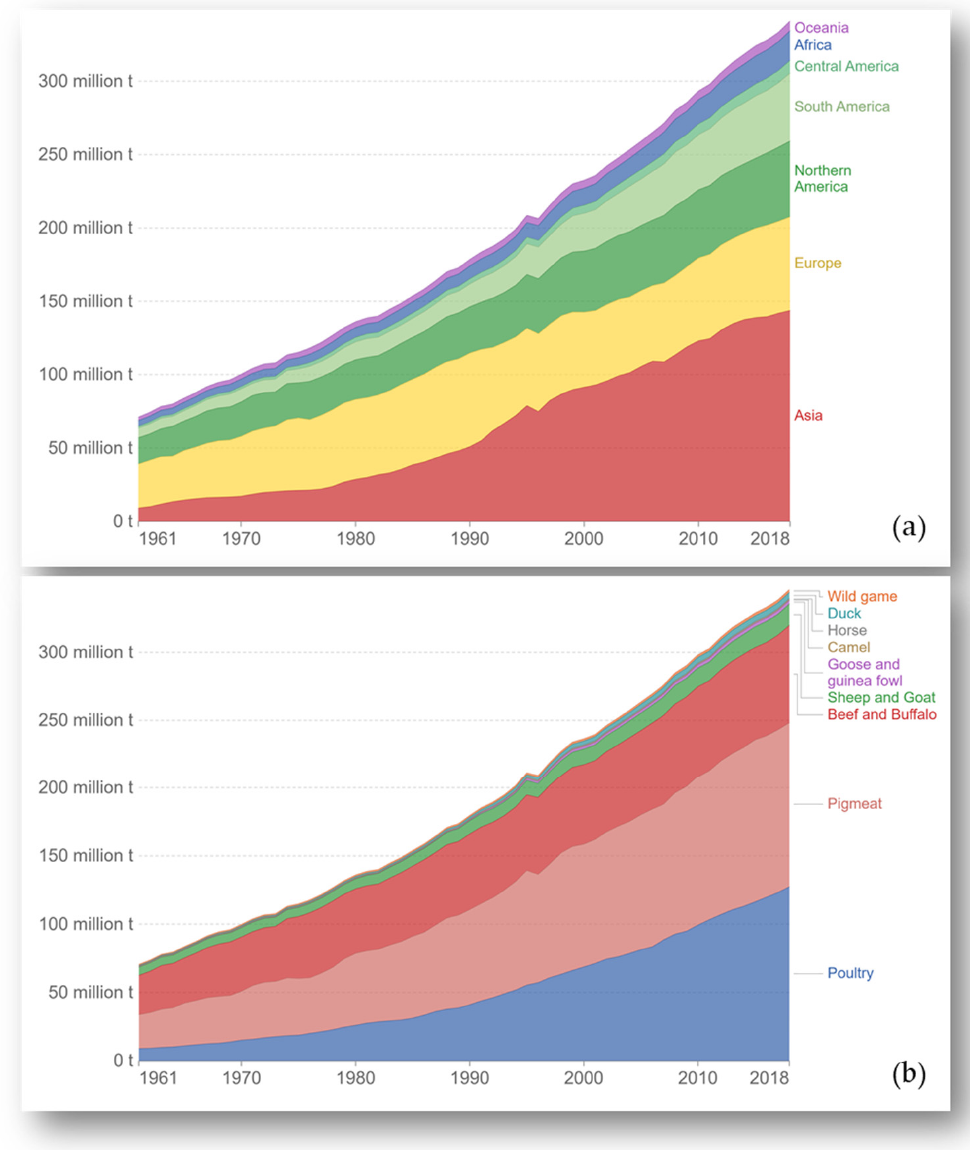
Figure 1. Global meat production ( a ) and meat production by livestock type ( b ). Source: https://ourworldindata.org/meat-production (accessed on 1 February 2022) [1].